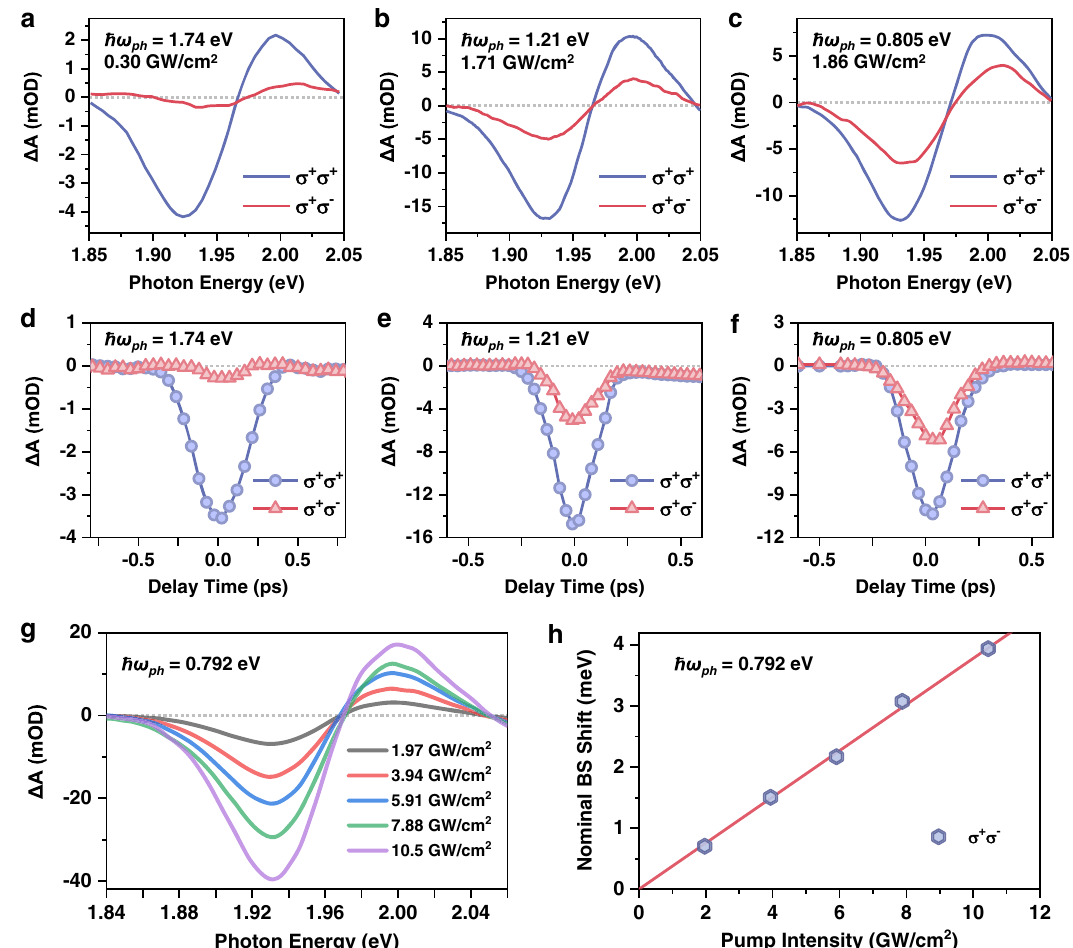
Fig. 3 | OpticalStark ( σ + σ + ) and Bloch – Siegert ( σ + σ − ) shiftsin CsPbI 3 QDs. Time- zero transient absorption (TA) spectra obtained with σ + σ + (blue) and σ + σ − (red) pump-probe con fi gurationswithpump photonenergies at ( a ) 1.74eV(714nm),( b ) 1.21eV (1027nm), and ( c ) 0.805eV (1540nm). The incident pump intensities are indicatedineachpanel. d , e , f Temporalpro fi lesofthesignalsreportedin a – c .Note that the 1.74eV pump pulse has been spectrally fi ltered using a grating in order to